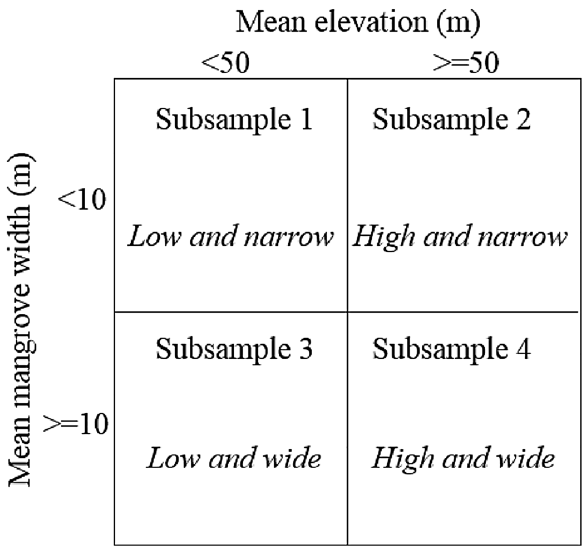
Figure 2. Subsamples for elevation and mangrove width